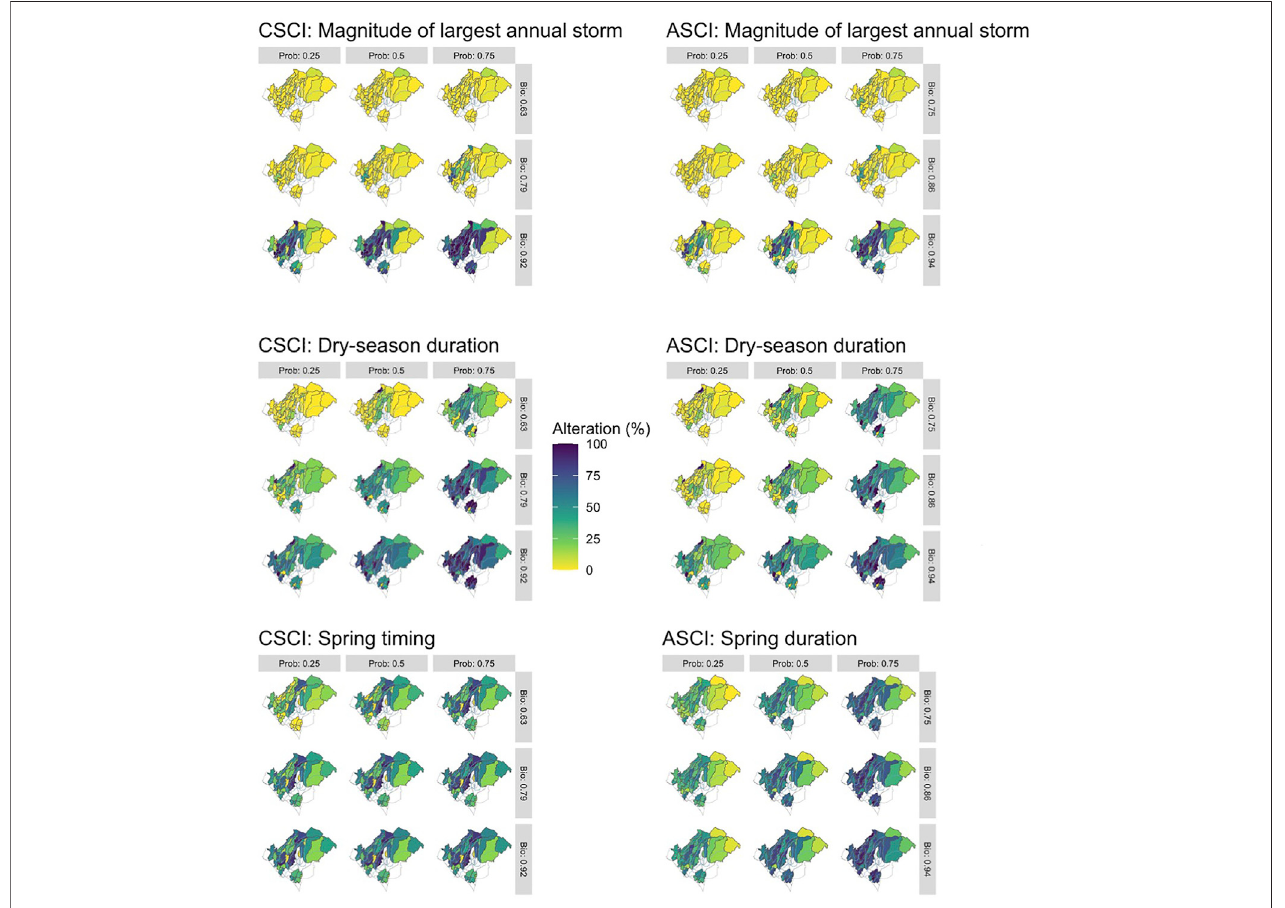
FIGURE 6 | Threshold combinations comparison for CSCI, ASCI and all chosen FFM. Horizontal values are the probability thresholds and vertical are the index thresholds. Percentage alteration is percentage of years deemed as altered following the alteration de fi nition.